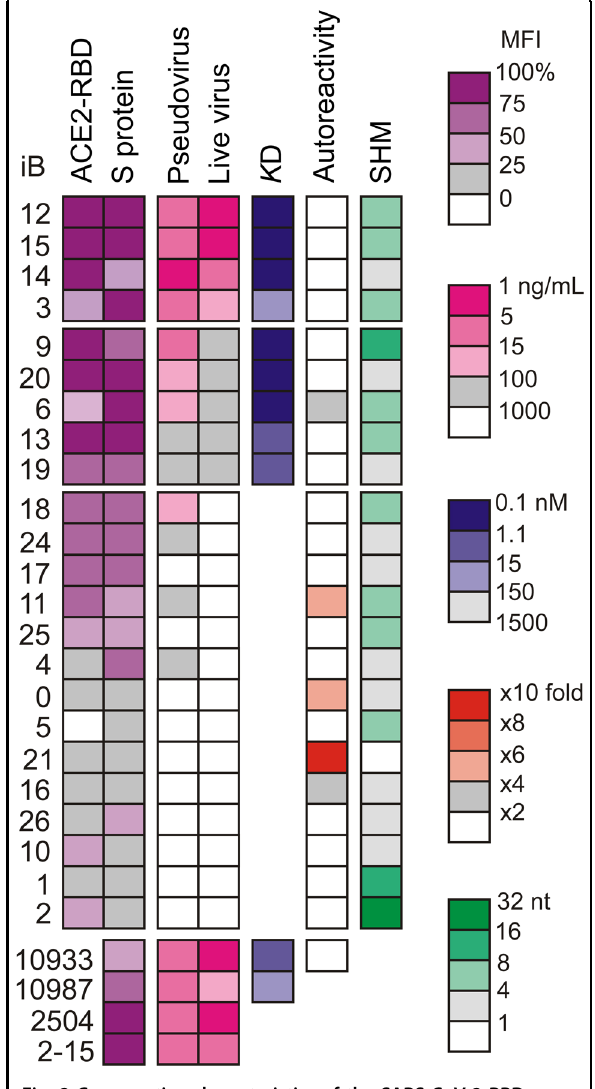
Fig. 2 Comparative characteristics of the SARS-CoV-2 RBD- binding human monoclonal antibodies. Heat maps are shown for monoclonal antibody blocking of ACE2/RBD interaction (%), staining of cell-surface expressed SARS-CoV-2 Spike (%), neutralization of Spike- pseudotyped lentiviral particles (IC 50 ) or authentic SARS-CoV-2 virus (IC 100 ), K D for the interaction with recombinant RBD (BLI measurements), autoreactivity (fold MFI increase above background), and SHM rate (number of nucleotide substitutions). Antibodies are grouped and ordered by neutralization potency and were either obtained in this study (iB0-26) or reported earlier (10933, REGN10933; 10987, REGN10987; 2504, COV2-2504; 2015, COVA2-15) 5,8,11 . All numerical values can be found in Supplementary Table